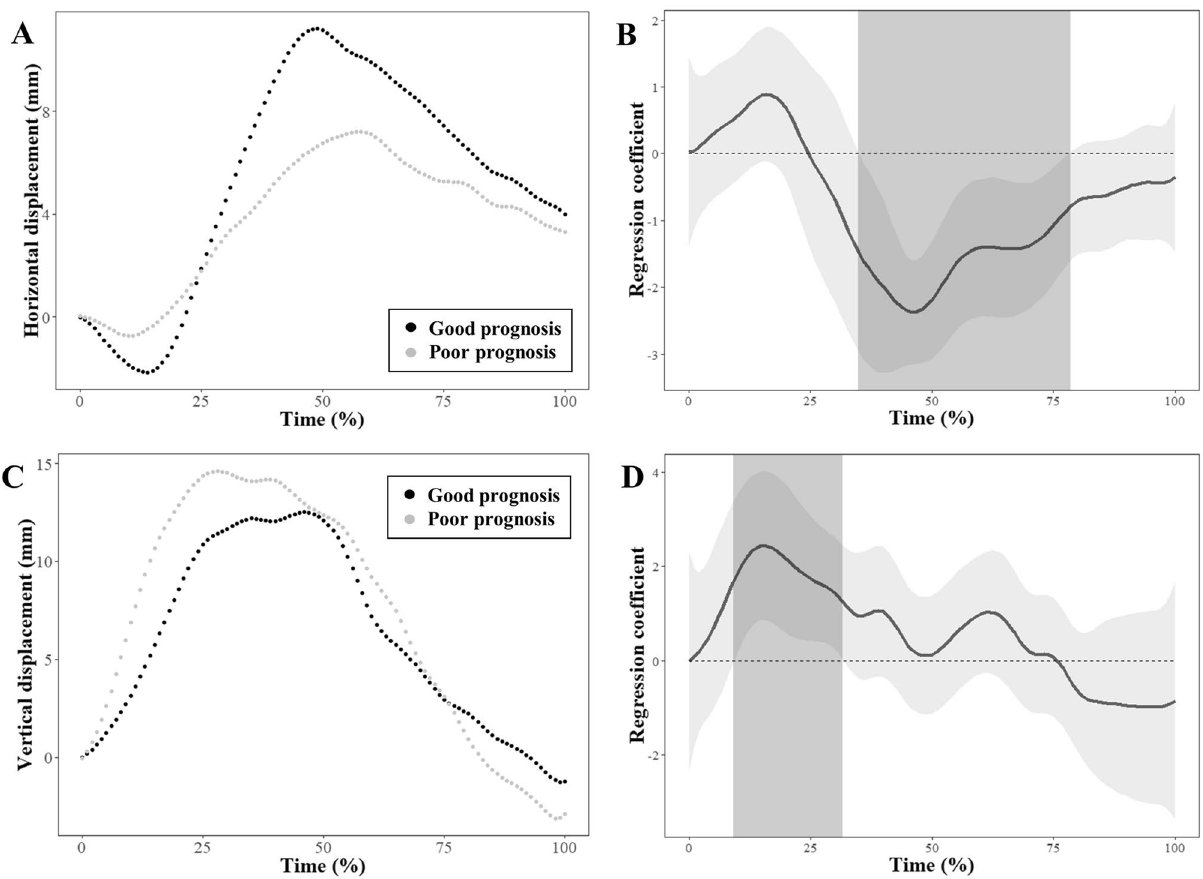
Figure 4. Results of functional regression analysis for horizontal and vertical hyoid displacements. Mean trajectories are illustrated for the horizontal ( A ) and vertical ( C ) displacements in age- and sex-matched stroke patients with good and poor prognosis. Estimated regression coefficient functions with 95% confidence intervals are shown for the horizontal and vertical displacements between stroke patients with good and poor prognosis ( B , D ). The light gray zones denote the time interval where the mean difference is significant between the